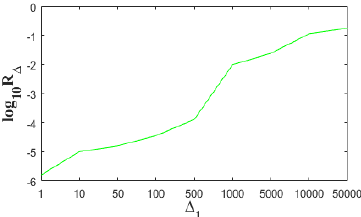
Figure 4. Block rotation constraint of various settings on ∆ 1